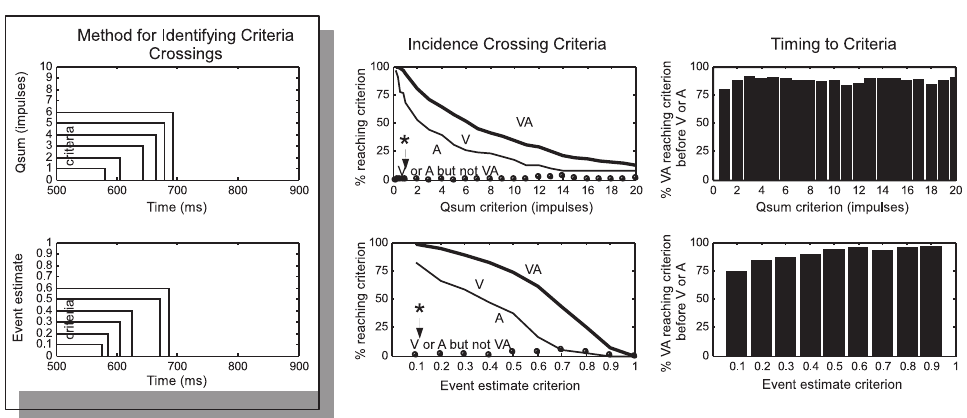
Figure 5. Multisensory responses reach higher levels earlier . Left: this analysis determined if and when responses quantified as qsums (top) or event estimates (bottom) reached threshold criteria levels. Middle and Right: multisensory responses crossed criteria levels more often (Middle) and earlier (Right) than did unisensory responses, and there were virtually no cases (see asterisk and arrow) where unisensory responses reached a criterion not also reached by the multisensory response. See text for more